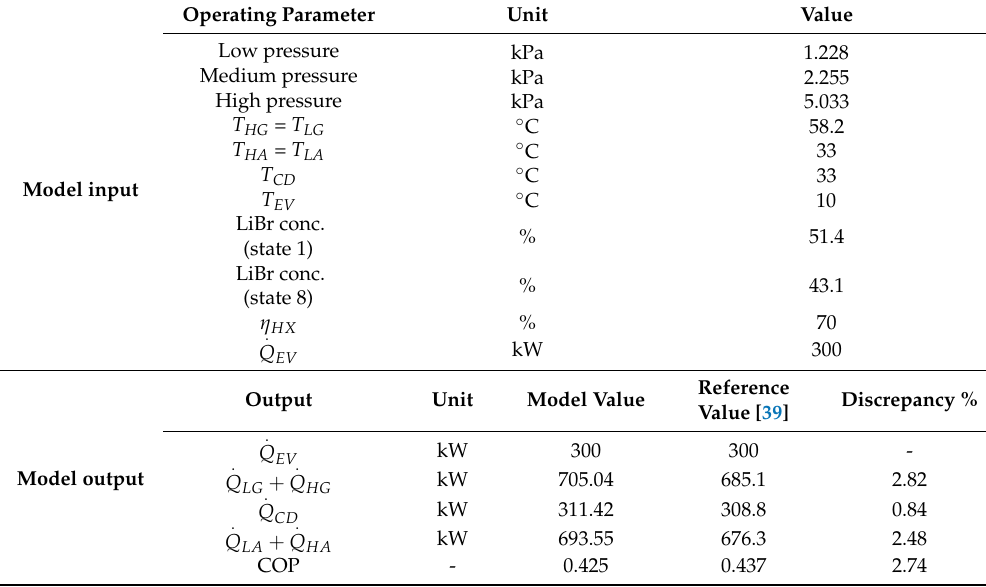
Table 4. Input and output to/from the model. COP: coefficient of performance.